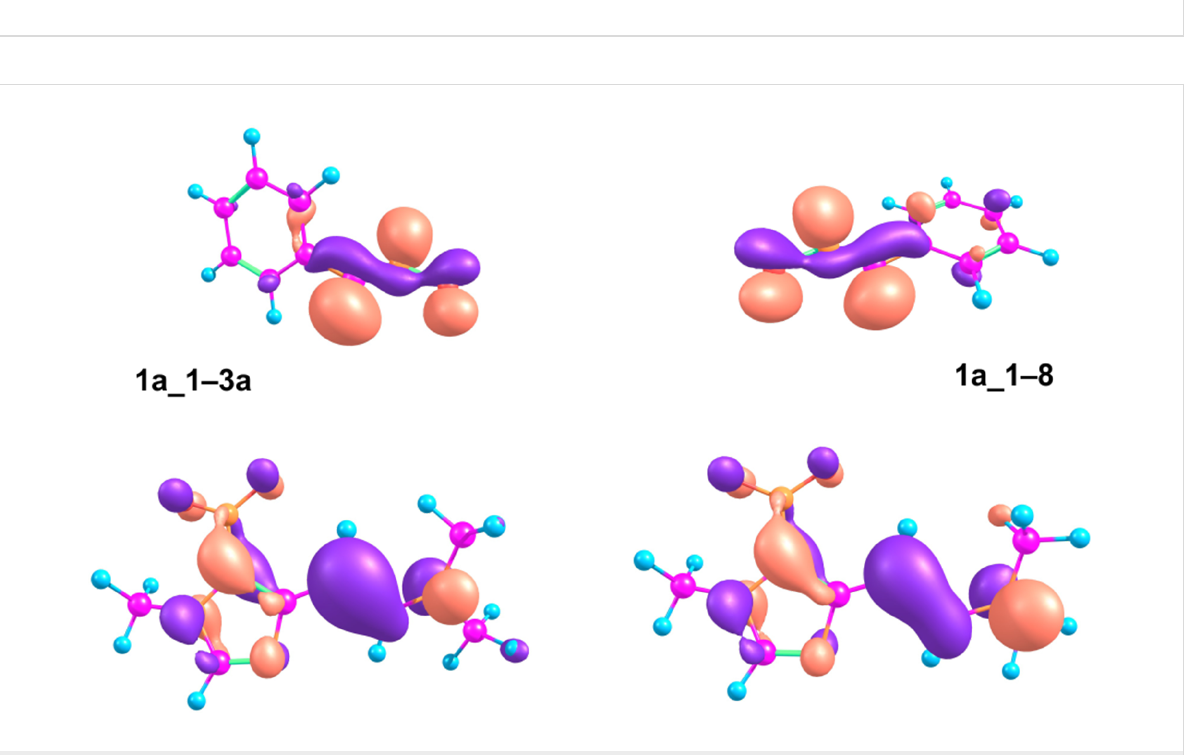
Figure 8: Isosurface plots of the HOMO of enamine 1a_1 (bottom) and the LUMO of nitrile oxide 6 (top) in the geometries of transition states 1a-1 − 3a (left) and 1a_1 − 8 (right), visualized at isovalue 0.05 by the use of Chemcraft 1.8 program